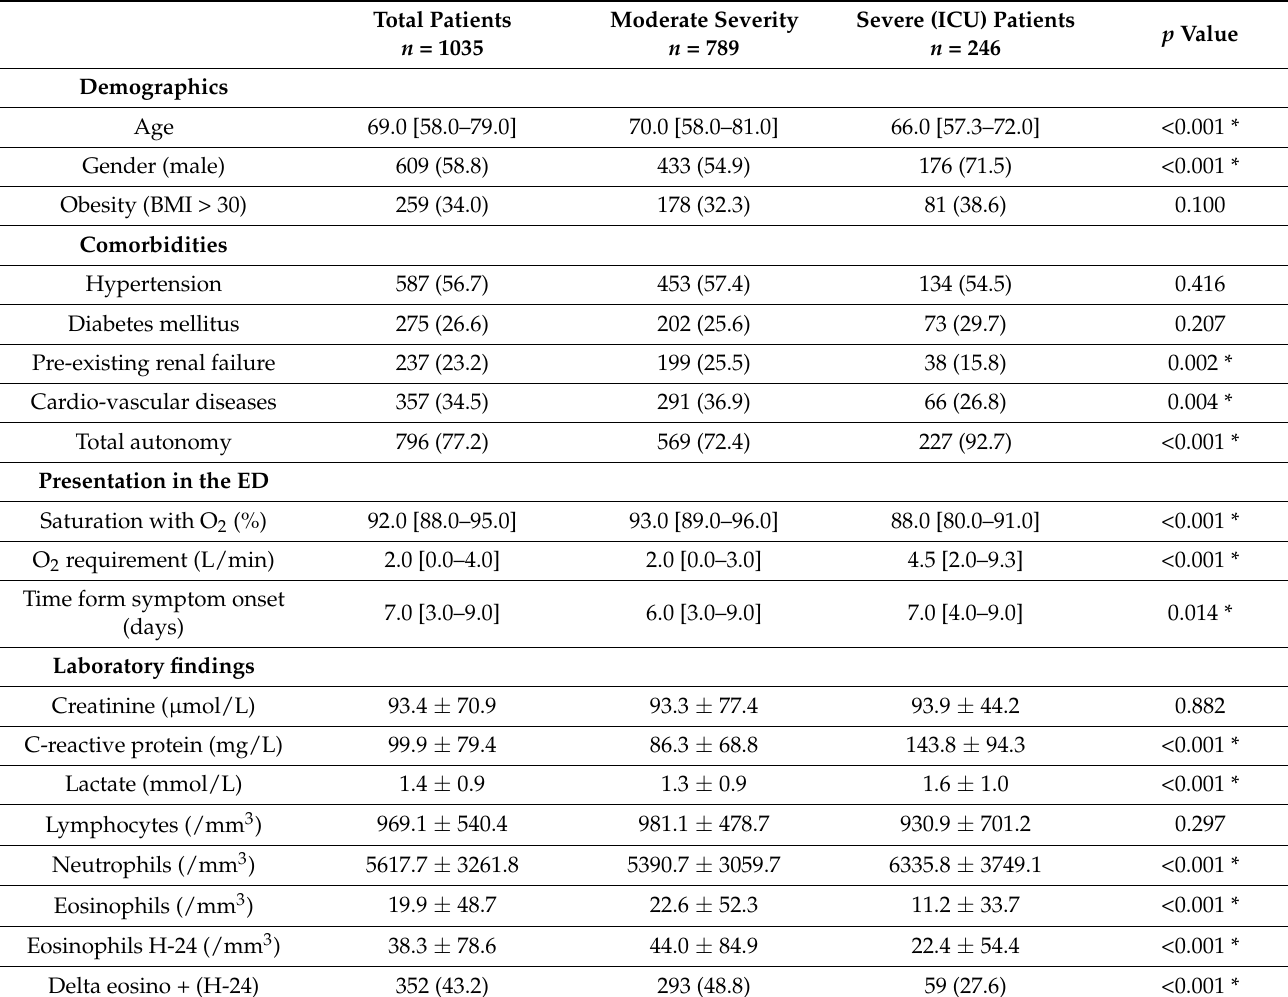
Table 1. General characteristics of study population with severe acute respiratory syndrome coronavirus 2 (SARS-CoV-2) infection and comparison according to disease